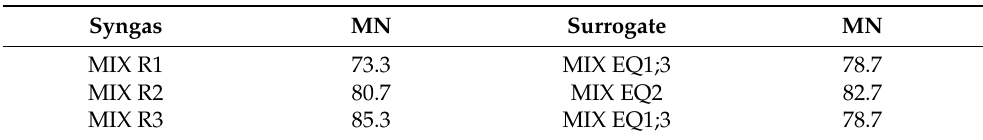
Table 5. Methane number of the three syngas mixtures (MIX R1, MIX R2, MIX R3) and two surrogates fuels (MIX EQ1;3, MIX EQ2) as estimated using Equation (5). Syngas MN